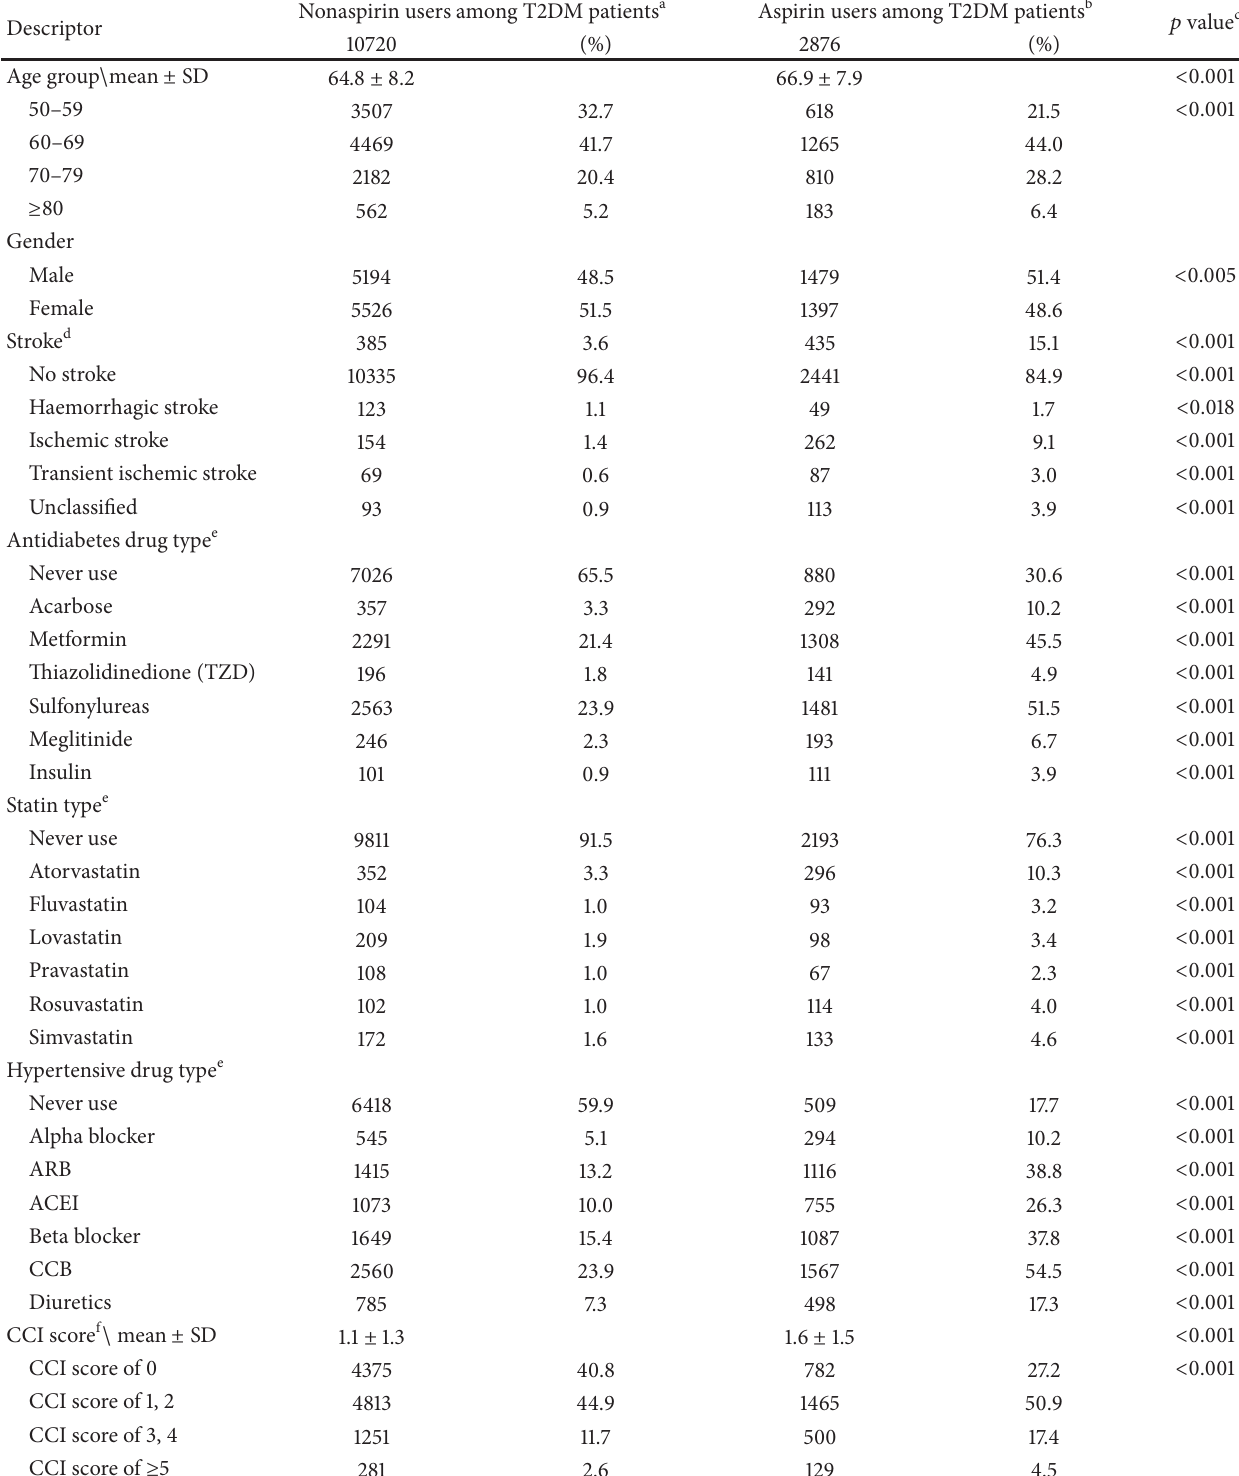
Table 1: Demographics of study subjects by aspirin using conditions between 1997 and 2008 in